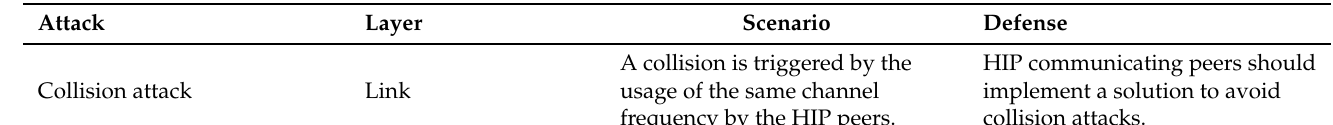
Table 16. Security